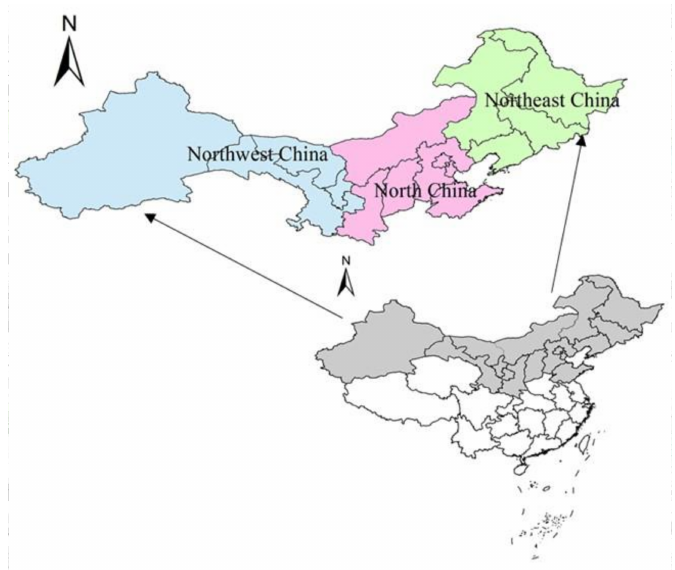
Figure 1. Location of the research area (The green area represents northeast China, the pink area for North China, the blue area for Northwest China,